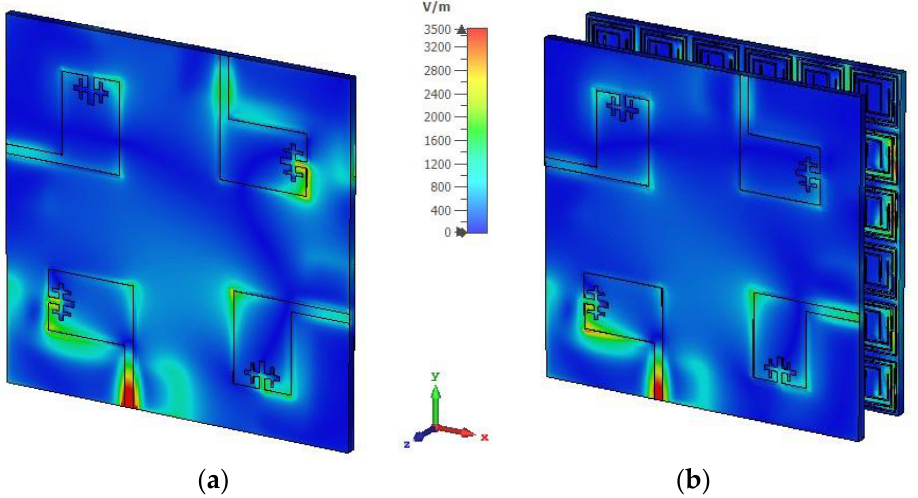
Figure 10. Electric field distributions at 4.5 GHz for proposed 4-port MIMO antenna ( a ) MIMO without MM and ( b ) MM-based MIMO.